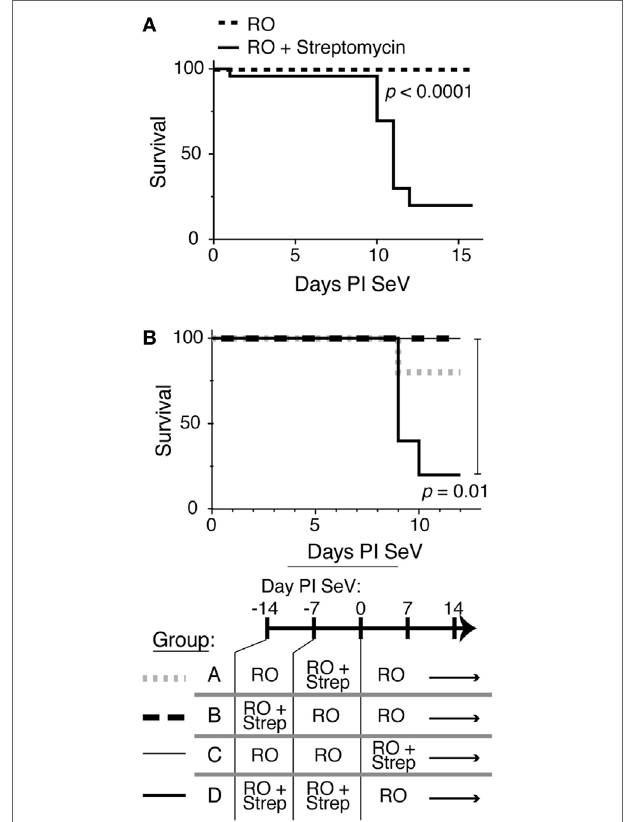
FigUre 1 | Disruption of intestinal microbiota results in increased mortality to respiratory Sendai virus (SeV) infection. (a) Kaplan–Meier survival curve for C57BL6 mice maintained on reverse osmosis (RO) water or RO water supplemented with 0.5 g/250 mL of the non-absorbable antibiotic streptomycin (RO + streptomycin) for 2 weeks prior to inoculation with 2 × 10 5 plaque forming units SeV (RO, n = 26; RO + streptomycin, n = 23; data combined from six separate experiments, n ≥ 3 mice/treatment each). (B) Two weeks of RO + streptomycin water before the viral infection is sufficient to drive the increased mortality. Kaplan–Meier survival curve for mice exposed to RO or RO + streptomycin (RO + strep) water for the indicated time periods ( n =